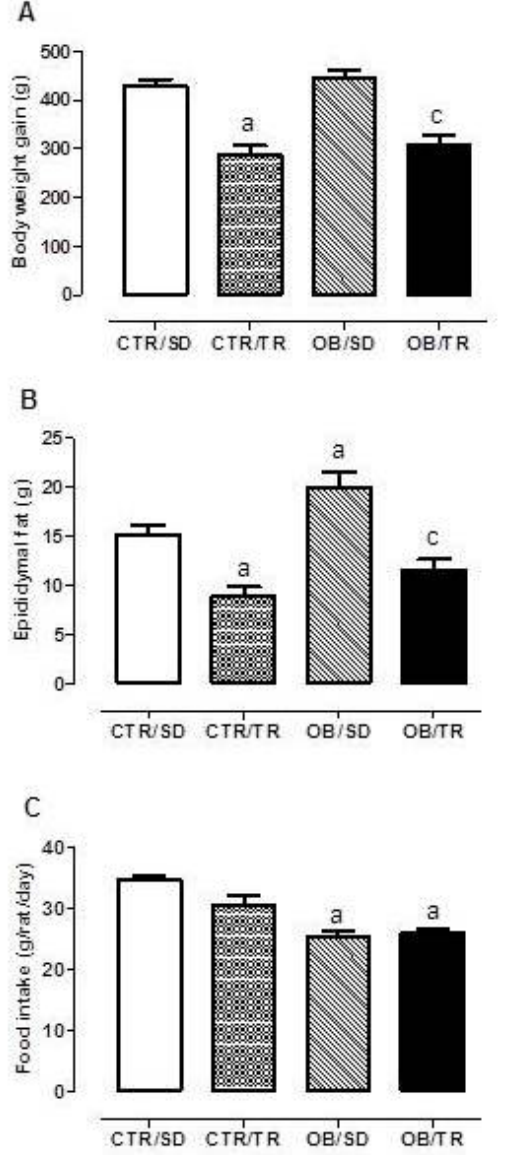
Figure 1. Body weight gain (panel A), epididymal fat pad (panel B) and daily food intake (panel C) control sedentary (CTR/SD), control trained (CTR/TR), obese sedentary (OB/SD) and obese trained (OB/ TR). Data are mean±SEM. ANOVA two-way, Bonferroni post test ( P <0.05). a different from CTR/SD, c different from OB/SD.